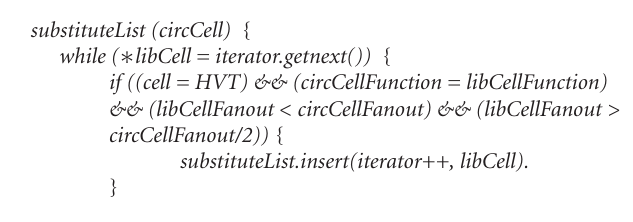
Algorithm 2: Pseudocode for the creation of the list of substitute